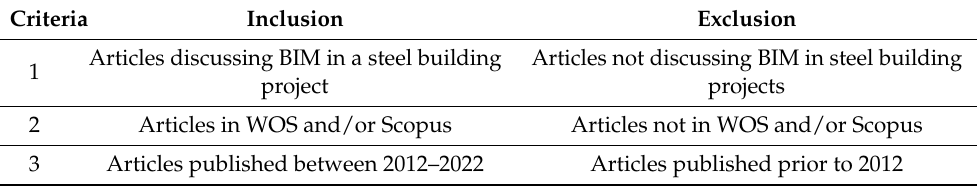
Table 2. Inclusion and Exclusion Criteria